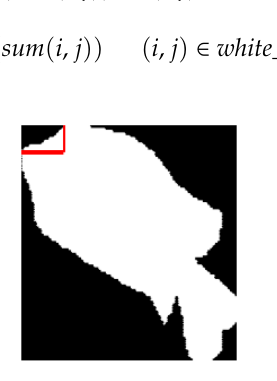
Figure 9. Head point of the object.